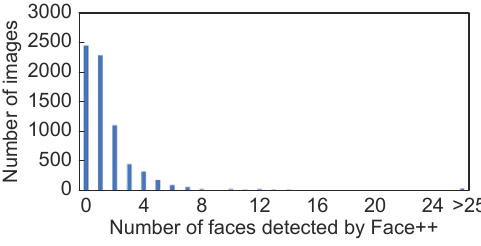
Fig. 6 Histogram of the number of